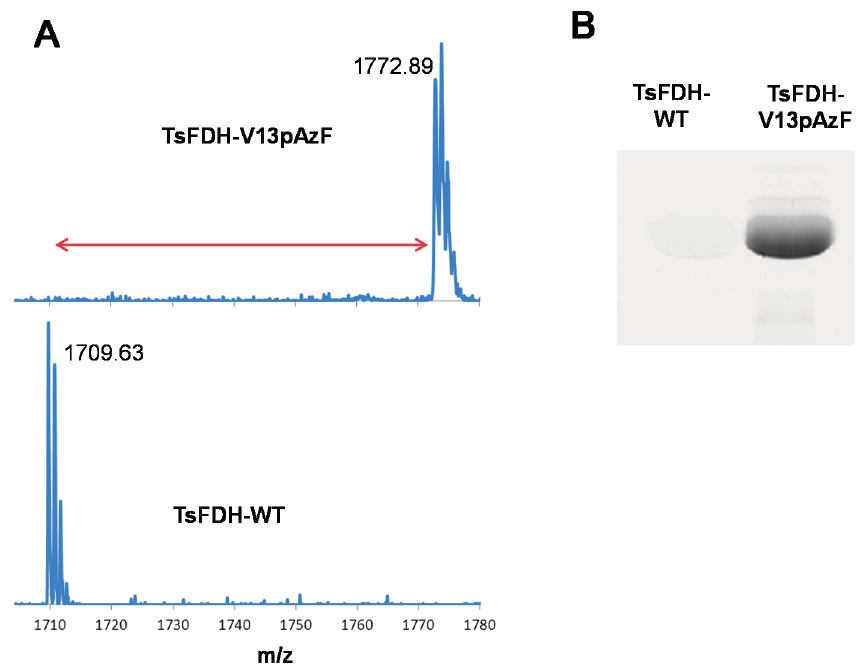
Figure 2. ( A ) Verification of pAzF incorporation into TsFDH by MALDI-TOF MS; mass spectra of one tryptic digest of TsFDH-V13pAzF (residues 4-18; ILCVLYDDP pAzF DGYPK) ( top ) and TsFDH-WT (residues 4-18; ILCVLYDDPVDGYPK) ( bottom ) and ( B ) in-gel fluorescence of TsFDH-WT and TsFDH-V13pAzF obtained by the SPAAC-mediated DBCO-dye